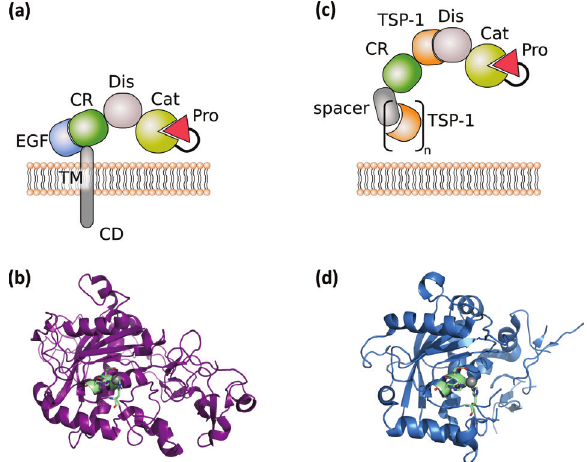
Figure 1. General structure of ADAM and ADAMTS pro- teases. (a) General domain structure of ADAM proteases. (b) X-ray structure (6BE6.pdb) of ADAM10, including cat- alytic, disintegrin and cysteine-rich domains. The catalytic zinc is highlighted in grey and the zinc-binding motif in pale green. (c) General domain structure of ADAMTS proteases. (d) X-ray structure of ADAMTS1 (2V4B.pdb), including catalytic and disintegrin domain. The catalytic zinc is high- lighted in grey and the zinc-binding motif in pale